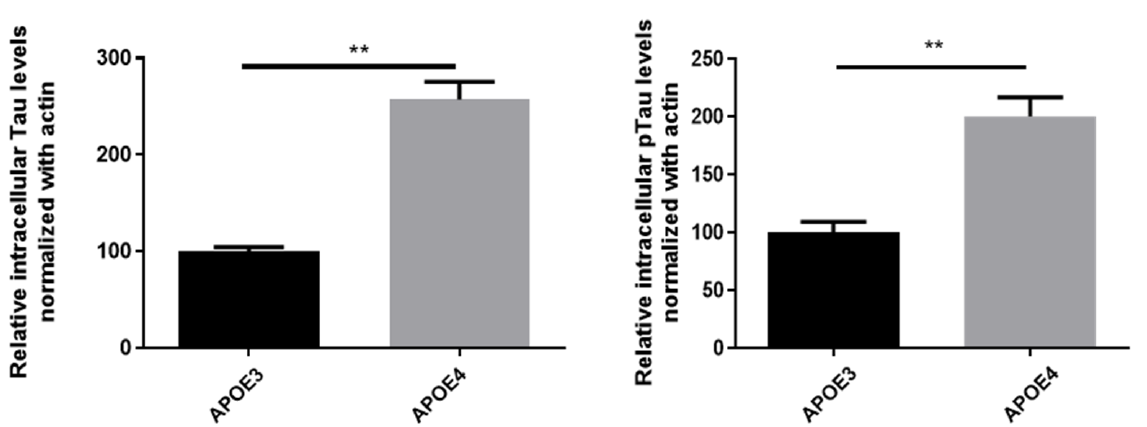
Figure 7. Effects of APOE genotype on intracellular levels of Tau and pTau. Primary cortical neurons cultures were obtained from P0-P1 newborn KI mice carrying the human APOE3 or APOE4 alleles. After 12 days in culture, tau and p-tau levels were assessed in cell lysates using Western blot and normalization with actin levels. Statistics: Mann and Whitney test **: p < 0.01, comparison with APOE3, 3 independent cultures with 2 to 3 replicates per culture.